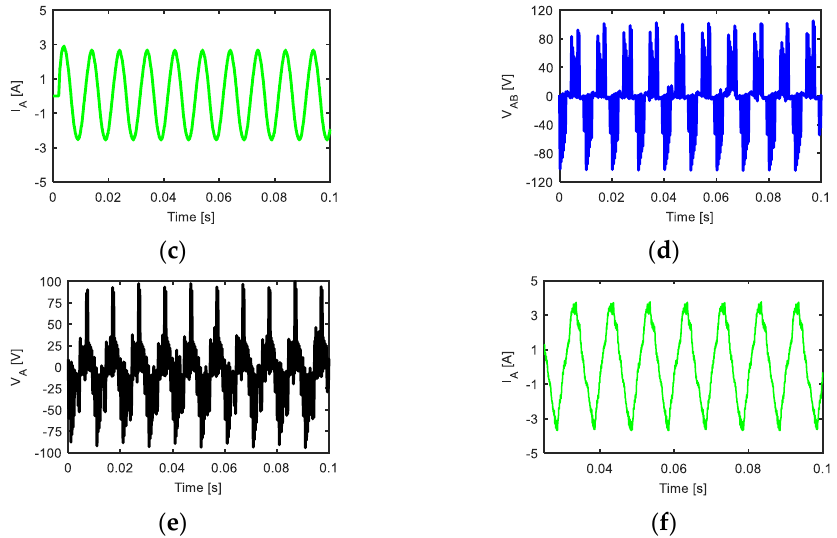
Figure 12. ( a – c ) Simulated and ( d – f ) measured results for a 100 Hz output frequency, ( a , d ) line voltage V AB , ( b , e ) phase voltage V A and ( c , f ) output phase current I A .